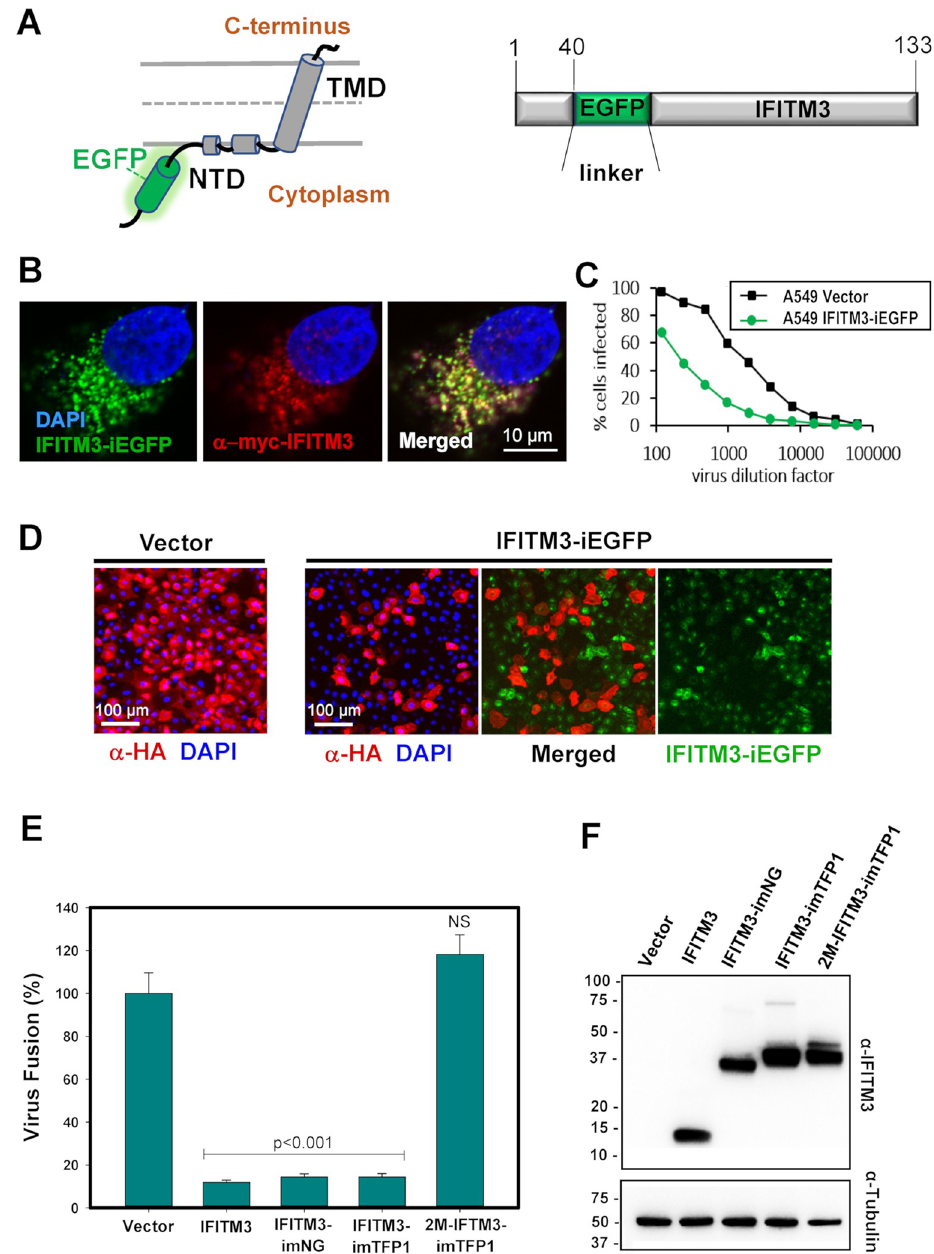
Fig 1. Construction and validation of IFITM3 tagged with florescent proteins. (A) Cartoon and schematic representation of IFITM3-iEGFP fusion protein. EGFP flanked with flexible linkers (GGGSGG) was inserted after residue 40 of IFITM3. NTD, N-terminal domain, TMD, transmembrane domain. (B) HeLa cells were transduced with both IFITM3-iEGFP (green) and N-terminally tagged myc-IFITM3 (red). Cells were fixed, permeabilized, immunostained with anti-myc tag antibody, and counterstained with DAPI. Co-localization of EGFP- and myc-tagged IFITM3 appears as yellow punctae. (C) IFITM3-iEGFP expressed in A549 cells inhibits viral infection of varied doses (dilutions of virus inoculum) of Influenza A/WSN/33 compared to an empty vector control. (D) A549 cells were transduced with empty vector (left) or IFITM3-iEGFP (three panels to the right), infected with influenza A/WSN/33, and immunostained 16 hours later for expression of HA antigen on the cell surface, which indicates productive virus infection. IFITM3-iEGFP expressing cells are protected from virus infection. (E) IAV pseudovirus fusion is inhibited in IFITM3 expressing A549 cells. HIV-1 pseudoviruses carrying BlaM-Vpr and IAV A/WSN/33 HA/NA were bound in the cold to A549 cells transduced with Vector, IFITM3, IFITM3-imNeonGreen (IFITM3-imNG), IFITM3-imTFP1 or the inactive mutant IFITM3 tagged with mTFP1, 2M-IFITM3-imTFP1. Fusion was initiated by shifting to 37˚C